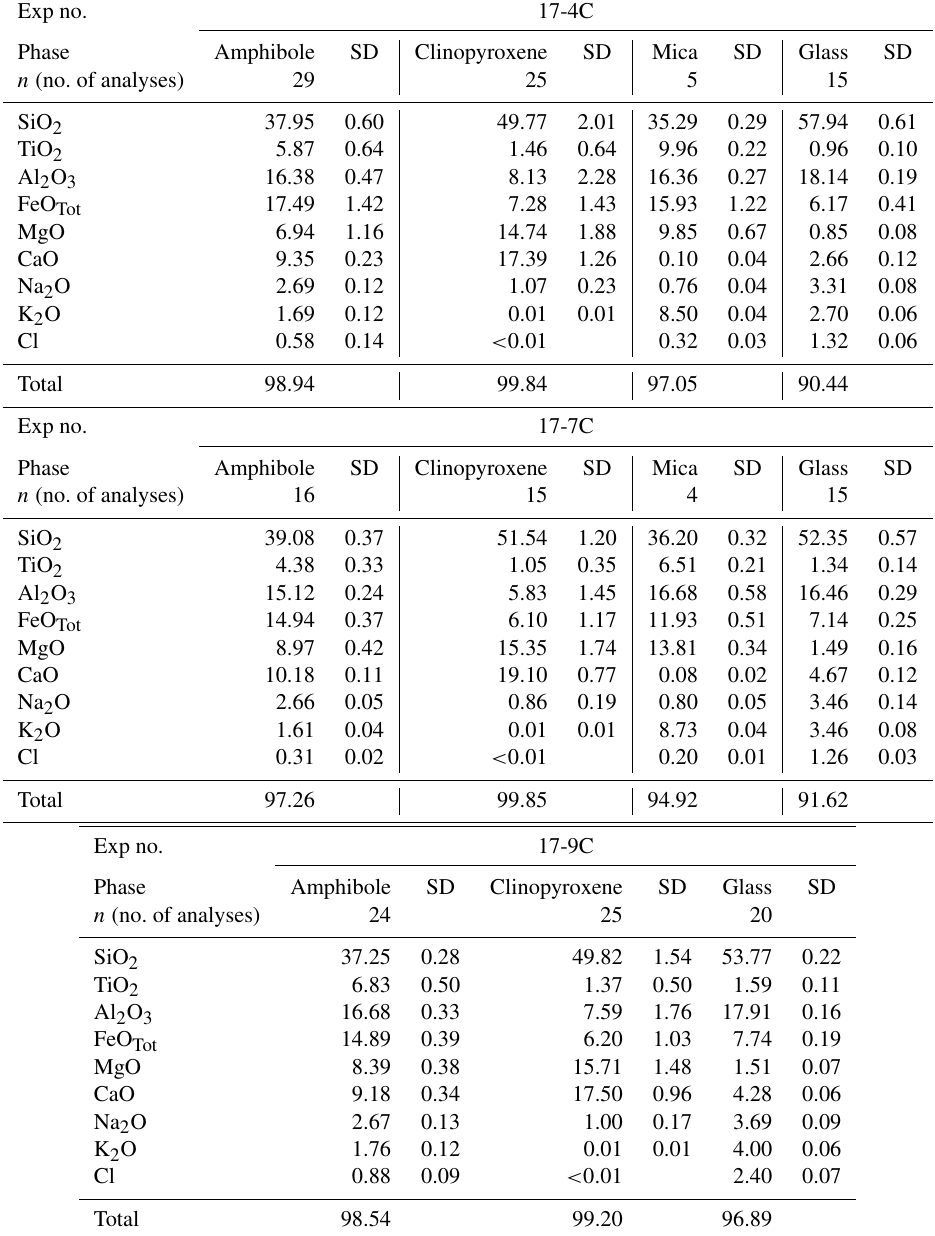
Table 2. Average major element (wt%) composition of run products. Exp